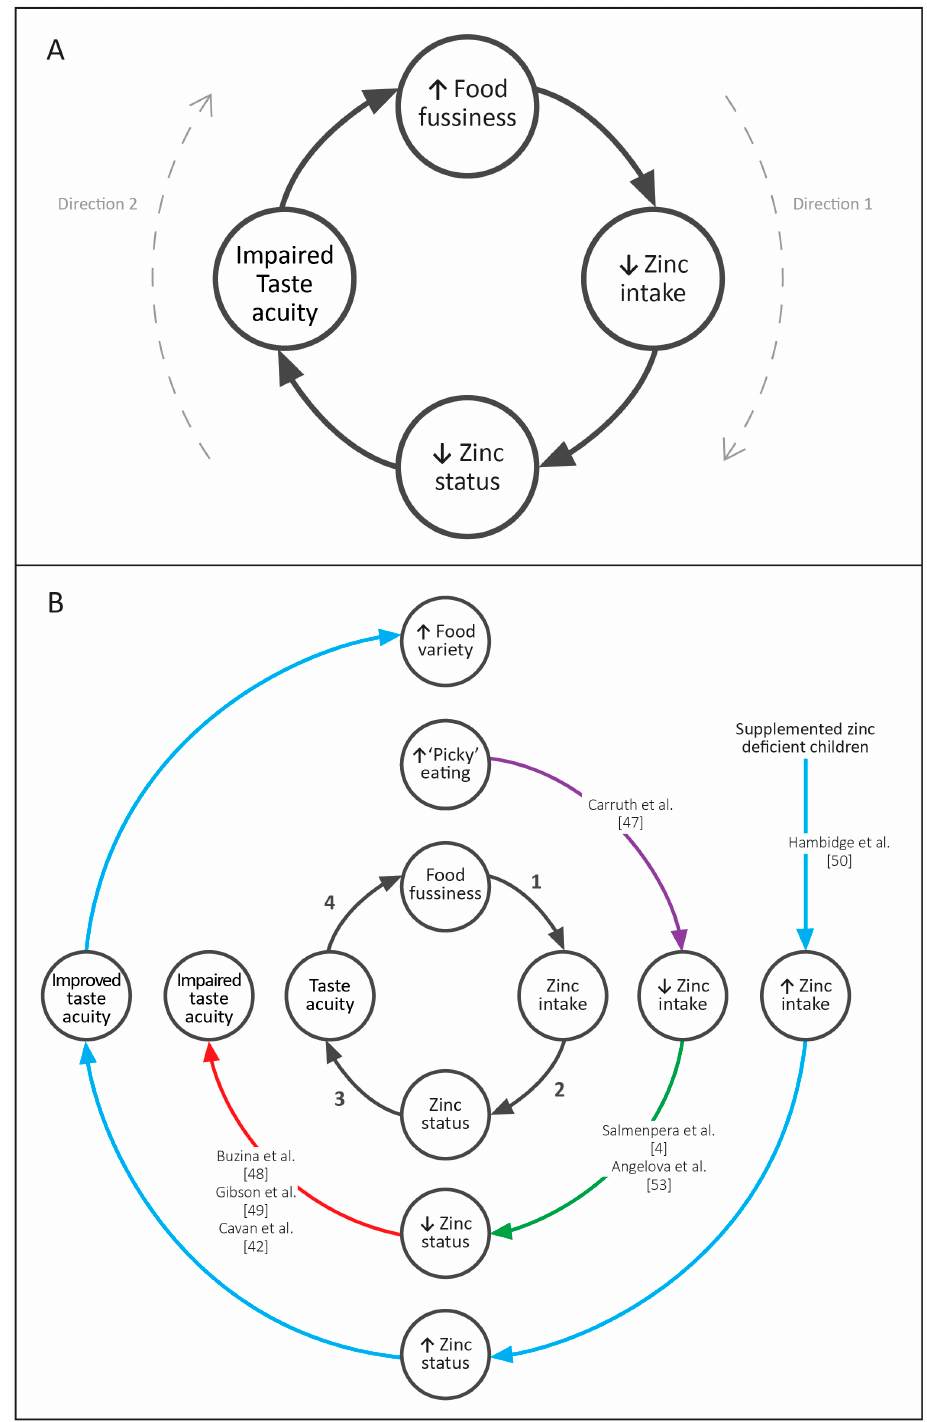
Figure 2. Four plausible pathways in the association between food fussiness and zinc status ( A ); with existing evidence for these associations [4,42,47–50,53] ( B